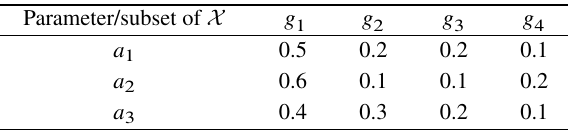
Table 1 Representation of set ( FFF ;;; AAA